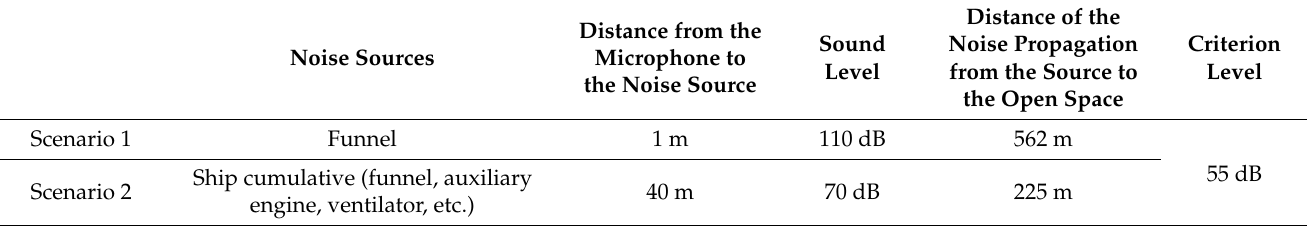
Table 2. Parameters considered for the simulations of noise propagation on the cargo terminals in the port of Split